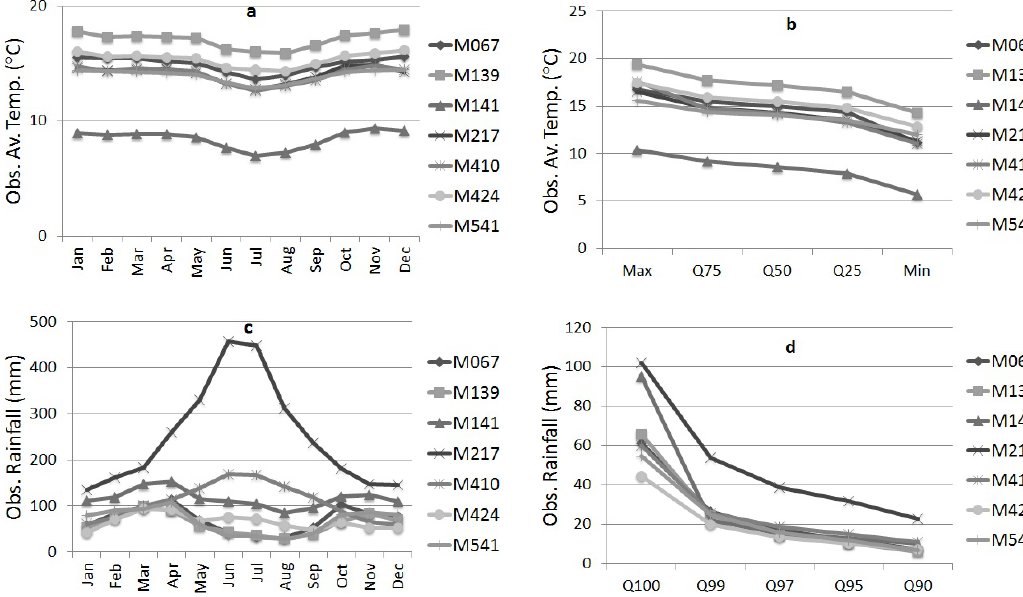
Fig. 5. Temperature and rainfall properties at observed sites (1960–1990). (a) Monthly average temperature distribution, (b) monthly tem- perature for different quantiles, (c) monthly rainfall depth distribution, (d) daily rainfall depths for different quantiles.